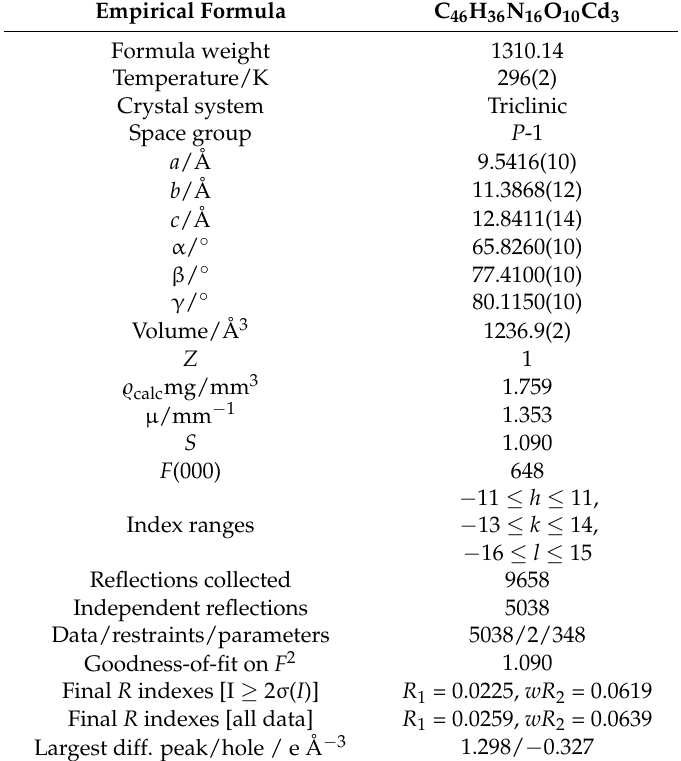
Table 3. Crystallographic data and structure refinement for 1